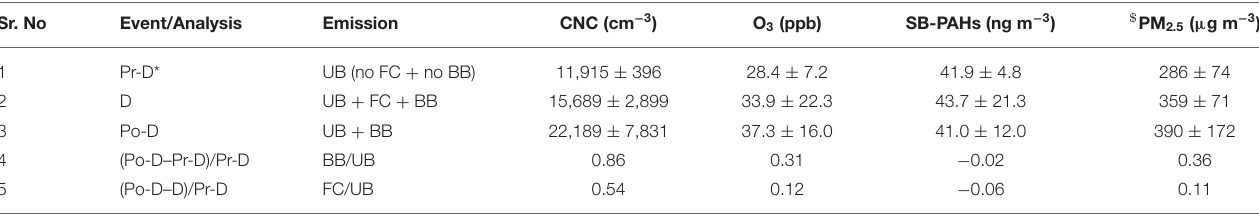
TABLE 4 | Lenschow-type analysis to estimate episodic source impact over the local background emission in central IGP at Kanpur. Sr.